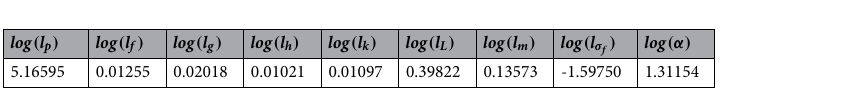
Table 2. Converged hyperparameters: off-nominal thrust bundle